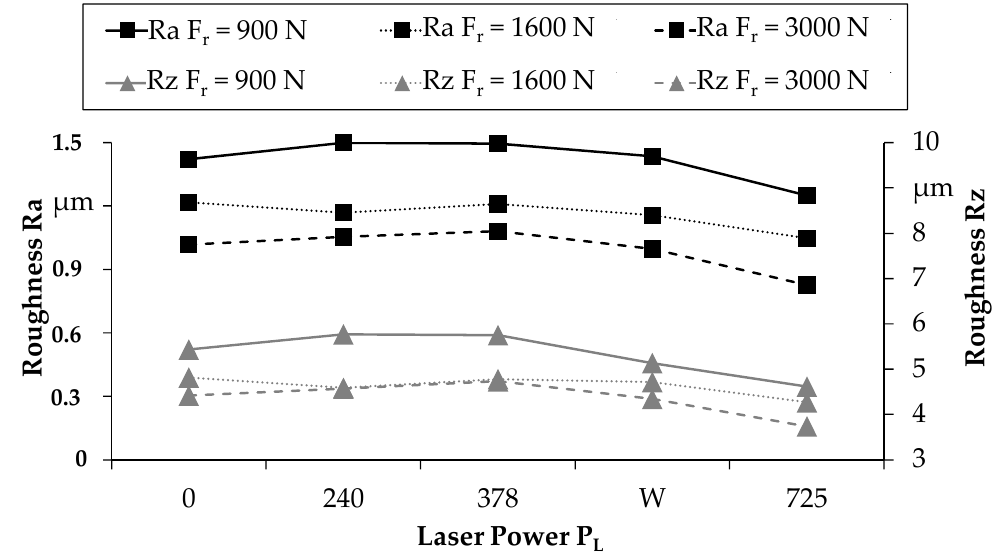
Figure 2. Roughness of samples with different thermomechanical loadings.